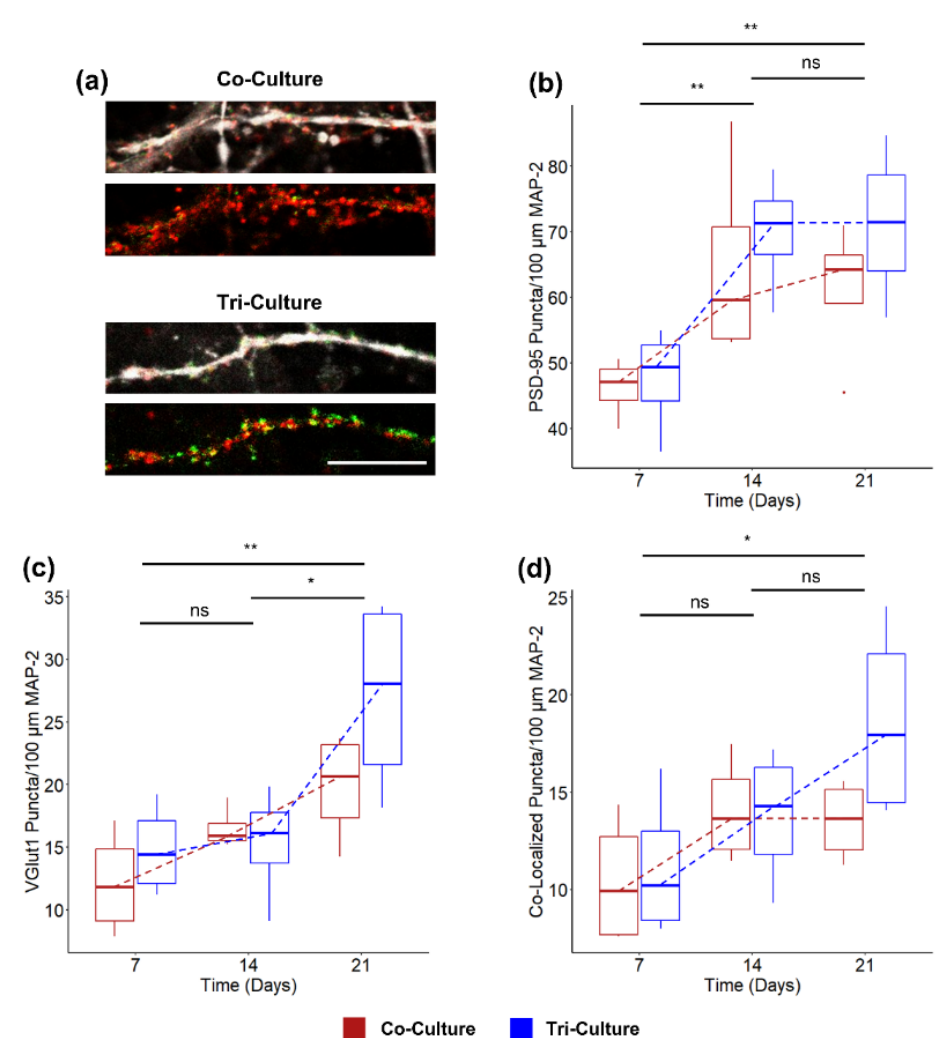
Figure 3. ( a ) Representative fluorescence images of co- and tri-cultures at DIV 21. The cultures are stained for the excitatory pre-synaptic marker VGlut1 (Green), post-synaptic marker PSD-95 (red). The above image also shows the co-localization with MAP-2 (white). (Scale bar = 10 µ m). Comparison of the density of ( b ) PSD-95 puncta, ( c ) VGlut1 puncta, and ( d ) co-localized puncta. In all, three cases, a two-way ANOVA found no interaction between culture type and time in culture. Therefore, the asterisk indicates the significance of the main effect between timepoints ( n = 4, from two independent dissections). * p < 0.05, ** p < 0.01, ns indicates no significant difference. Trendlines are visual guides